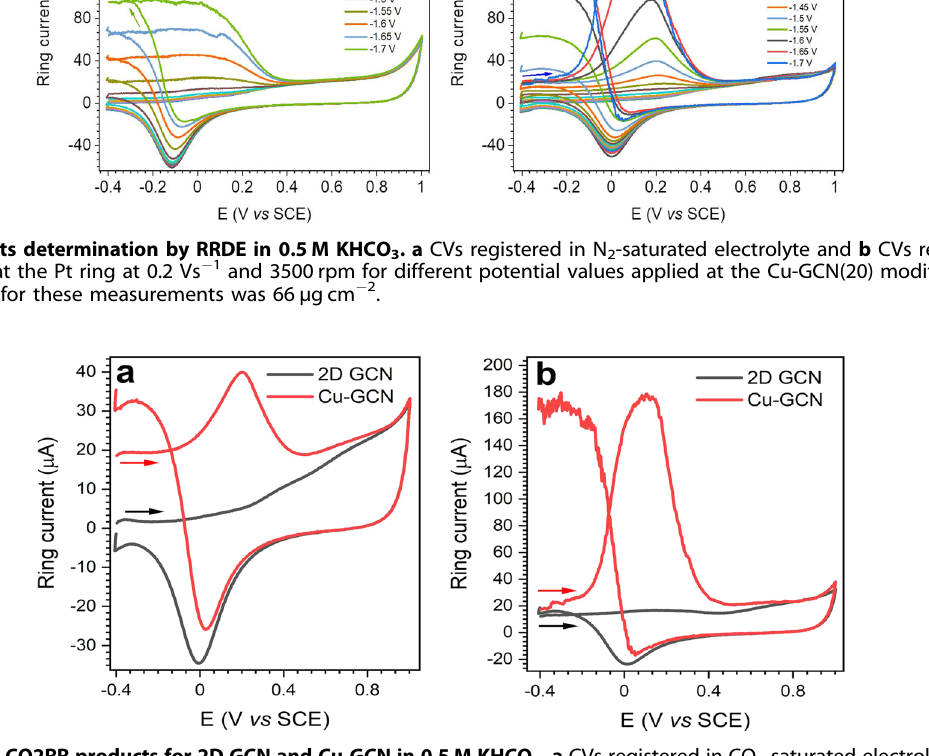
Fig. 6 Comparison of CO2RR products for 2D GCN and Cu-GCN in 0.5 M KHCO 3 . a CVs registered in CO 2 -saturated electrolyte at the Pt ring (0.2 Vs − 1 , 3500 rpm) for E disk = − 1.5 V vs SCE and b for E disk = − 1.7 V vs SCE with a 2D GCN or Cu-GCN(20) modi fi ed GC disk. A catalyst loading of 66 µg cm − 2 was used in both cases.